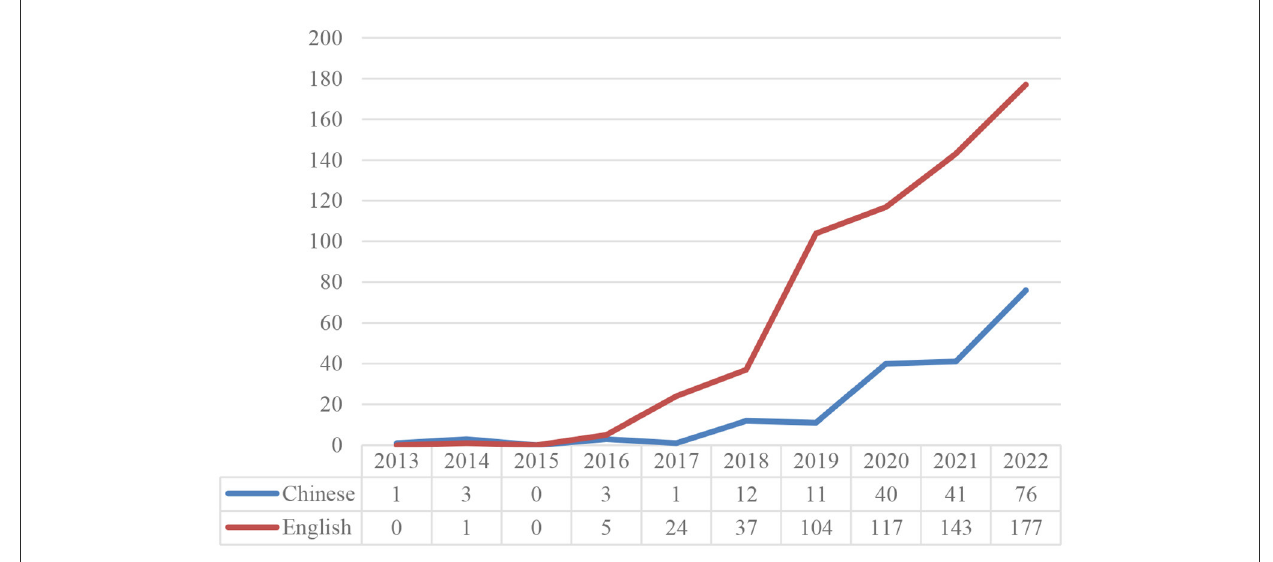
FIGURE1 Publication of articles in Chinese and